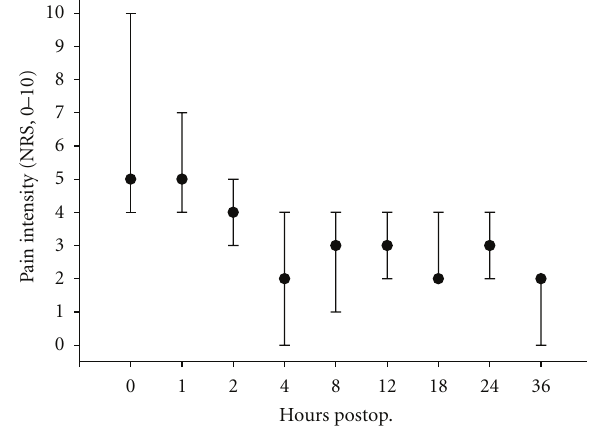
Figure 1: Intensity of pain at rest. Intensity of pain was assessed on a numerical rating scale (0–10) 0, 1, 2, 4, 8, 12, 18, 24, 36hr after end of surgery. Data are expressed as median (interquartile range). n = 15 ( n = 11 and n = 14 after 12 and 18hr, resp.).